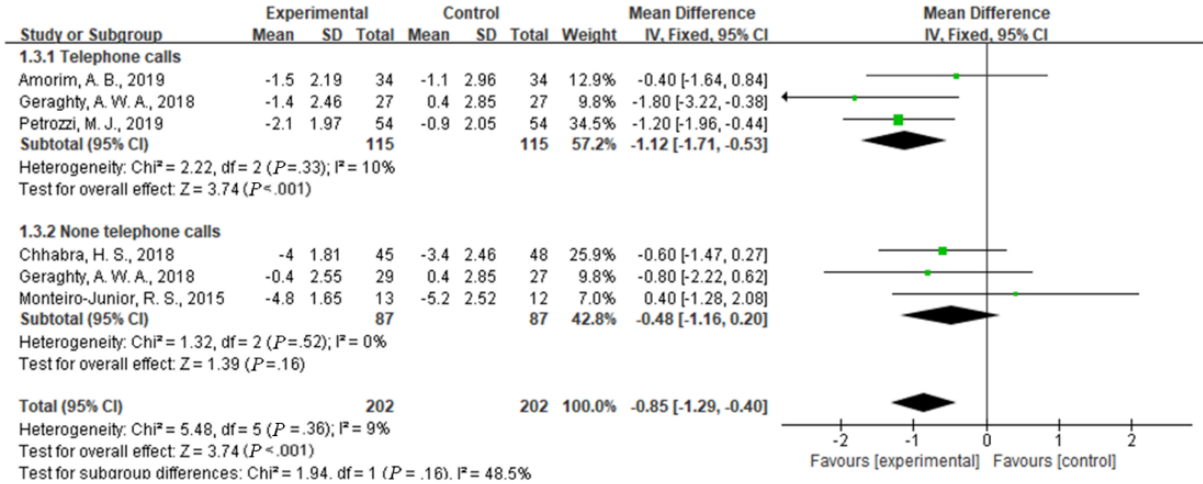
Figure 5. Efficacy of telephone calls use in reducing pain